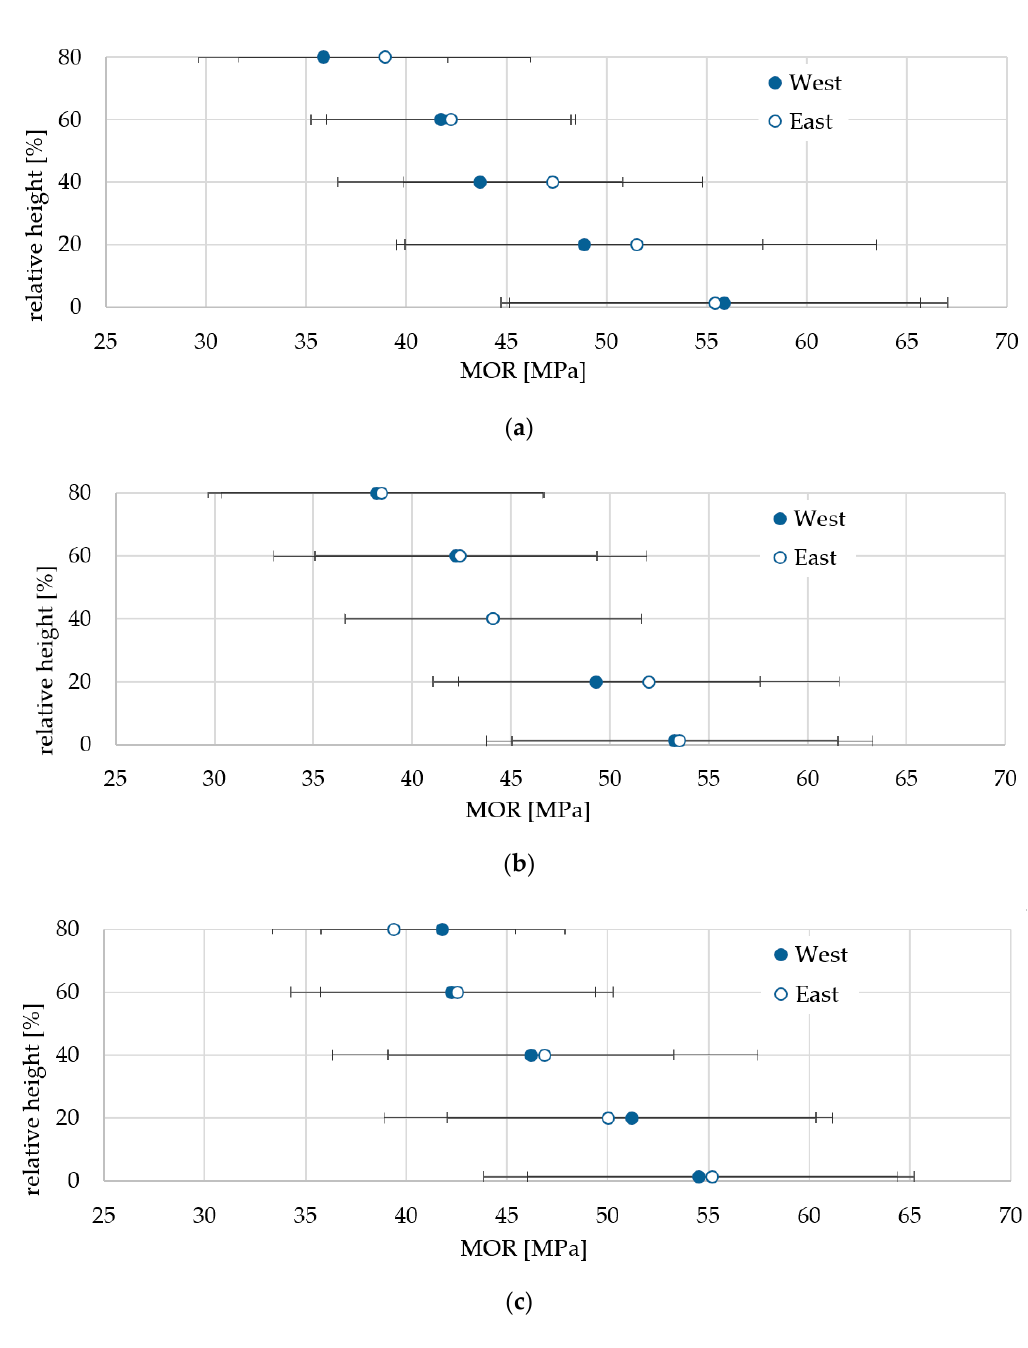
Figure 6. Variability in modulus of rupture (MOR) along the stem (the lines represented ± standard deviation): ( a ) plot A (0–20 m); ( b ) plot B (30–50 m); ( c ) plot C (60–80 m).